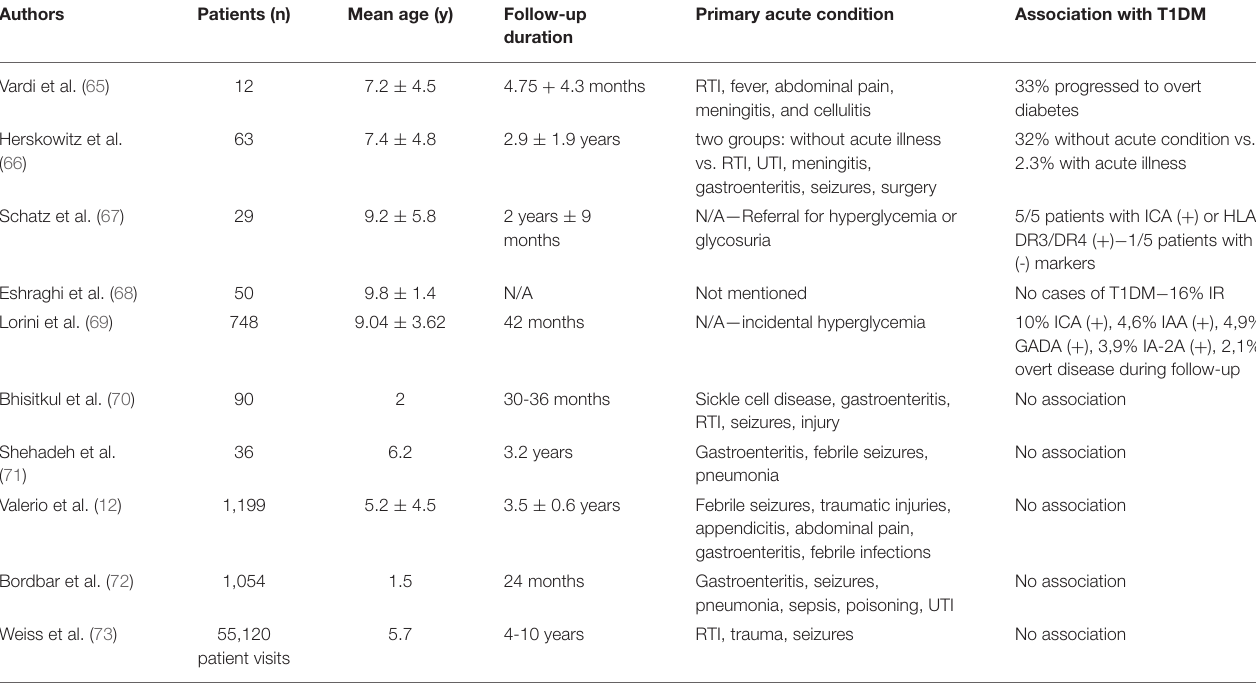
TABLE 1 | Major studies on the association between stress hyperglycemia and incidence of type 1 diabetes mellitus.